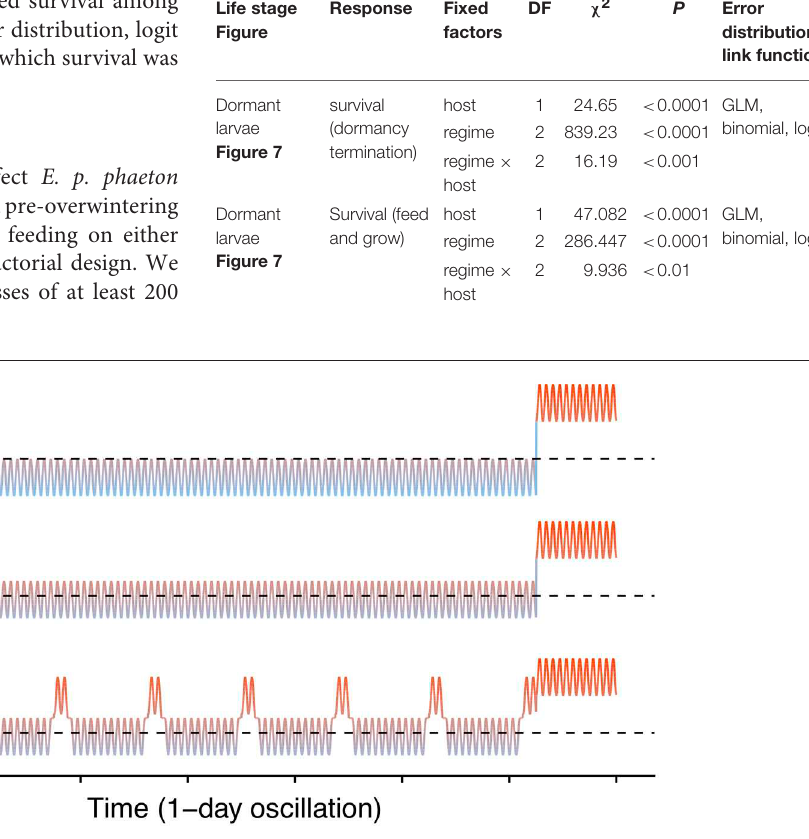
Frontiers in Ecology and Evolution |